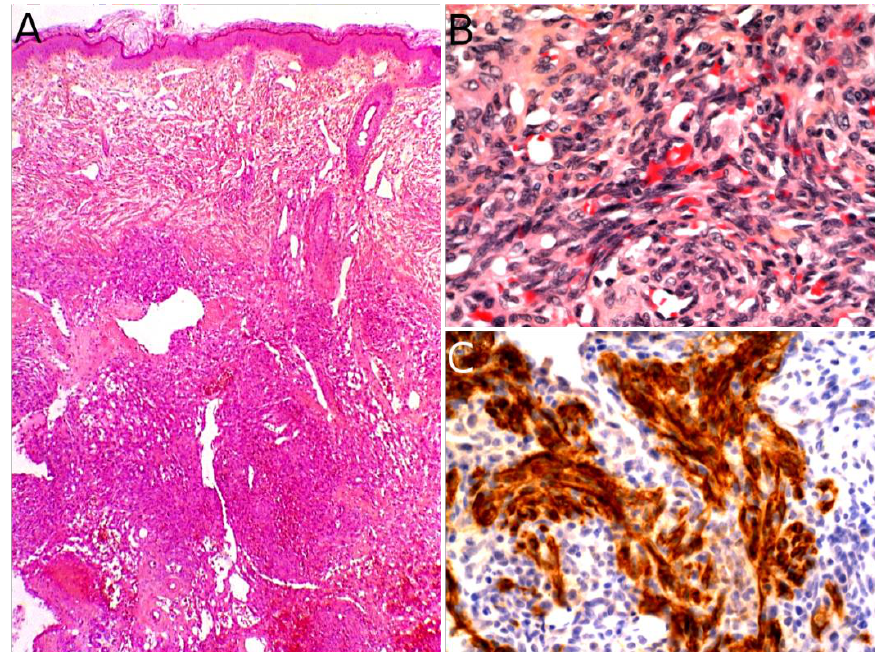
Figure 7. Kaposiform hemangioendothelioma: ( A ) Deep dermal and subcutaneous, infiltrating pro- liferation of spindle cells arranged in nodules (×25); ( B ) spindle endothelial cells with no mitoses (×200); ( C ) positivity for the lymphatic marker podoplanin in the spindle cells (×200).